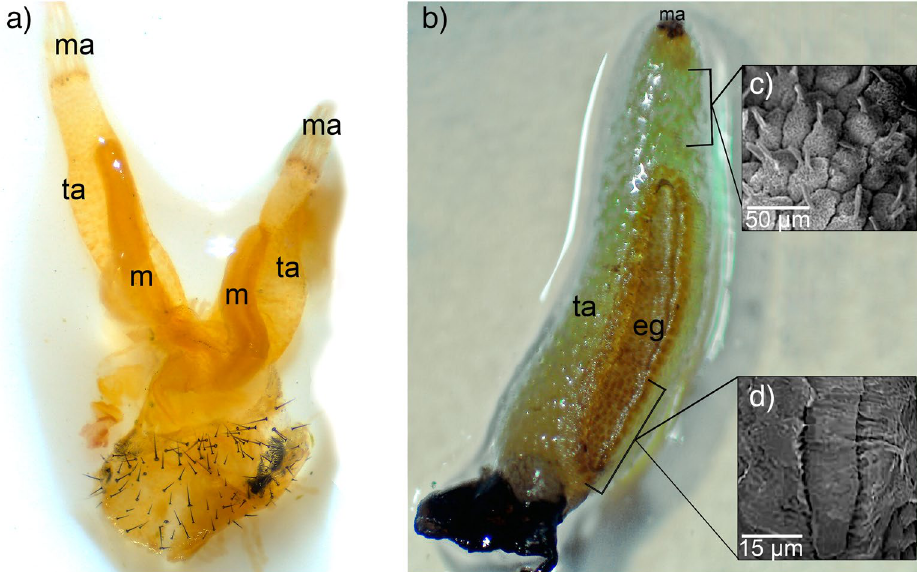
Figure 4. Morphology and ultramorphology of the osmeterium in Battus polydamas archidamas . ( a ) General view of a dissection of the osmeterium, note the muscles running inside of the osmeterium, which were torn from the larval body and the osmeterium apex. ( b ) One arm of the osmeterium that shows two sectors composing it. Scanning electron microscope detailed images of the tubular arm ( c ) and the ellipsoid gland ( d ). Abbreviations: eg, ellipsoid gland; m, muscle; ma, attachment of the osmeterium to the muscle; ta, tubular